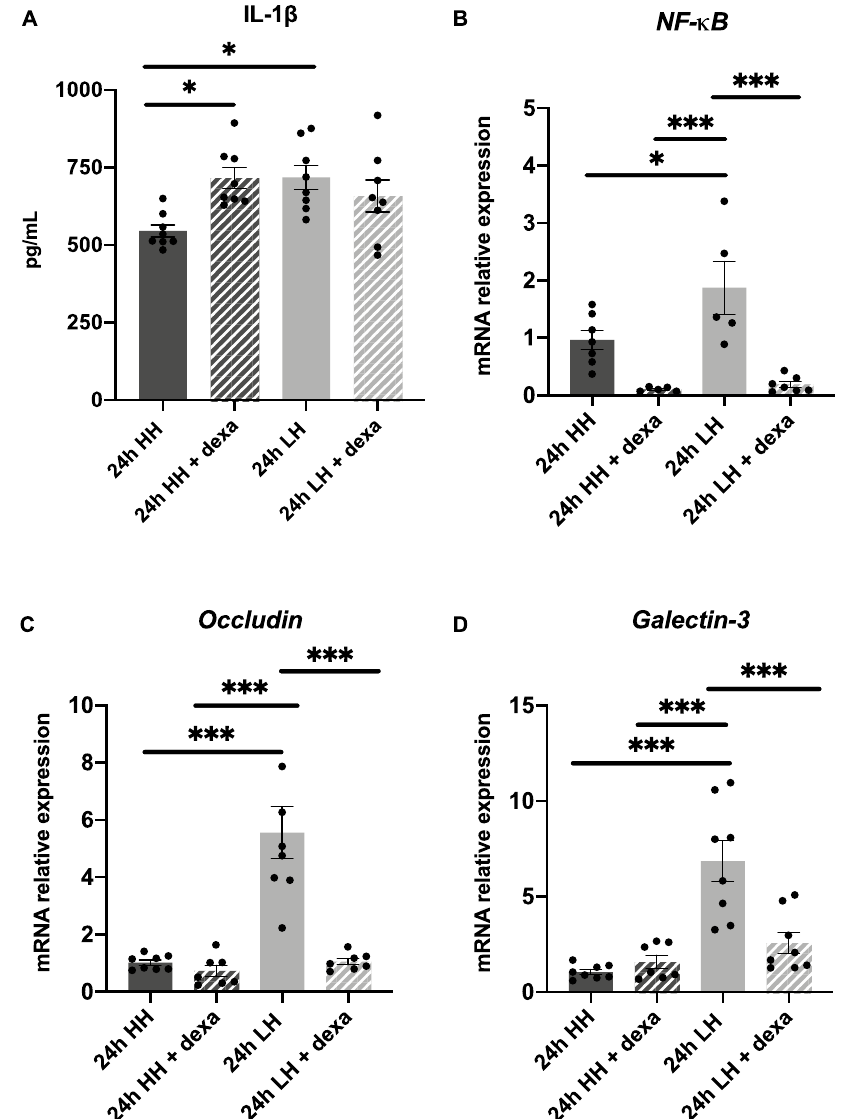
Figure 5. Dexamethasone (dexa) counteracts the effects caused by LH. ( A ) No significant difference in IL-1β secretion was observed in samples incubated at LH + dexa in comparison to LH group (LH + dexa= 658.10 pg/mL ± 51.65/LH= 718.10 pg/mL ± 38.85; p = 0.68) ( n = 8 for LH/ n = 8 for LH + dexa/ n = 8 for HH/ n = 8 for HH + dexa). ( B ) A significant inhibition of increase in NF-κB mRNA expression was observed at the LH + dexa group (0.18 ± 0.05) in comparison to LH group (1.87 ± 0.46 p < 0.001). ( C ) The increase in occludin mRNA expression due to LH was significantly prevented by dexa (1.05 ± 0.11), in comparison to LH group (5.56 ± 0.91; p < 0.001). ( D ) LH significantly induced mRNA expression of galectin-3 (6.85 ± 1.07; p < 0.001). This effect could be prevented by the treatment with dexa (2.57 ± 0.55; p < 0.001). n = 5–8 for LH/ n = 7–8 for LH + dexa/ n = 7–8 for HH/ n = 5–7 for HH + dexa. LH: low humidity. HH: high humidity. Dexa: dexamethasone. The bars represent the mean values, and the SEM is shown. * p < 0.05 *** p <